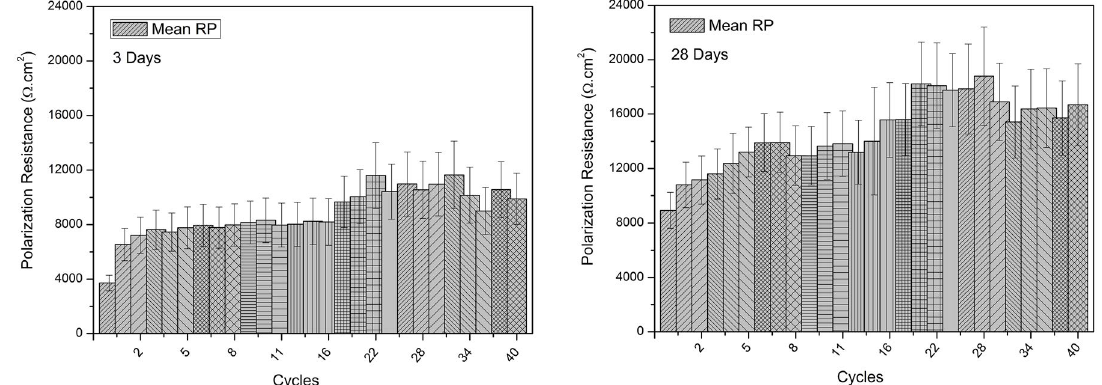
column graphs for 3 days. Figure 8. R p